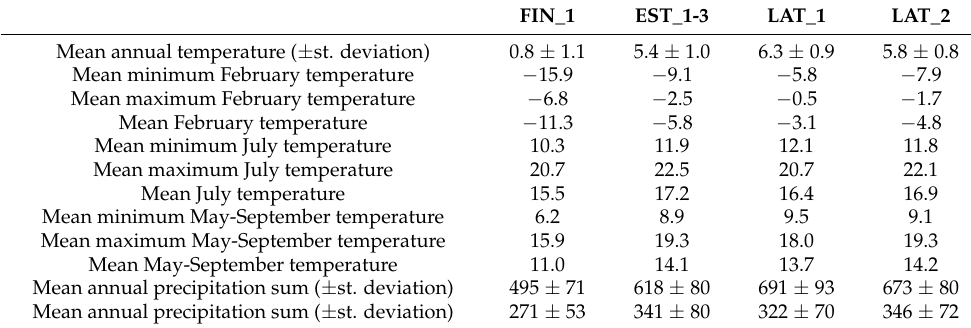
Table 2. Climatic description of the studied conventionally managed stands of Scots pine according to the gridded climatic data. Temperature is in ◦ C and precipitation is in mm. FIN_1 LAT_1 Mean annual temperature ( ± st.